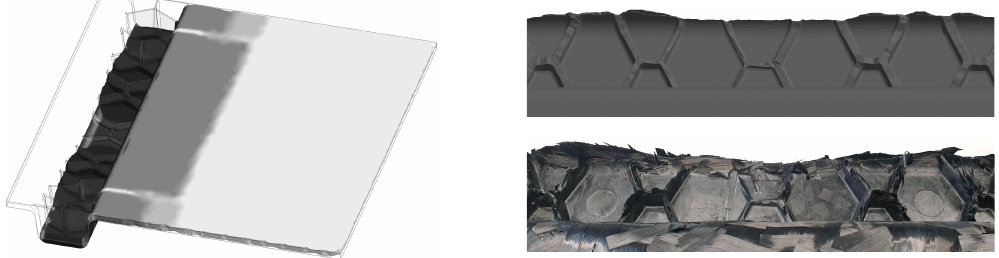
Figure 14. 3D TIMON CompositePRESS fill simulation status compared to a real HexMC short shot using 8.65 mm shims.